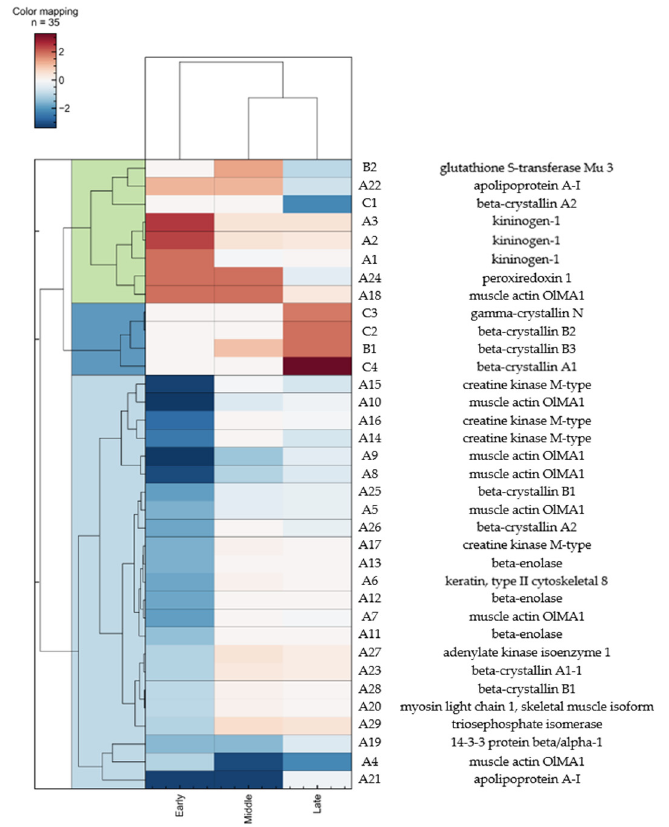
Figure 3. Clustered heat map of differential protein spots on 2-DE images of medaka upon time- dependent exposure to K. mikimotoi . Red and blue colors represent upregulation and downregulation, respectively, while color intensity denotes change on a base-2 log scale. The horizontal axis refers to stages of intoxication, while the vertical axis refers to protein spots. Color labelling on the left shows early upregulated proteins in green, late upregulated proteins in dark blue, and early downregulated proteins in light blue.